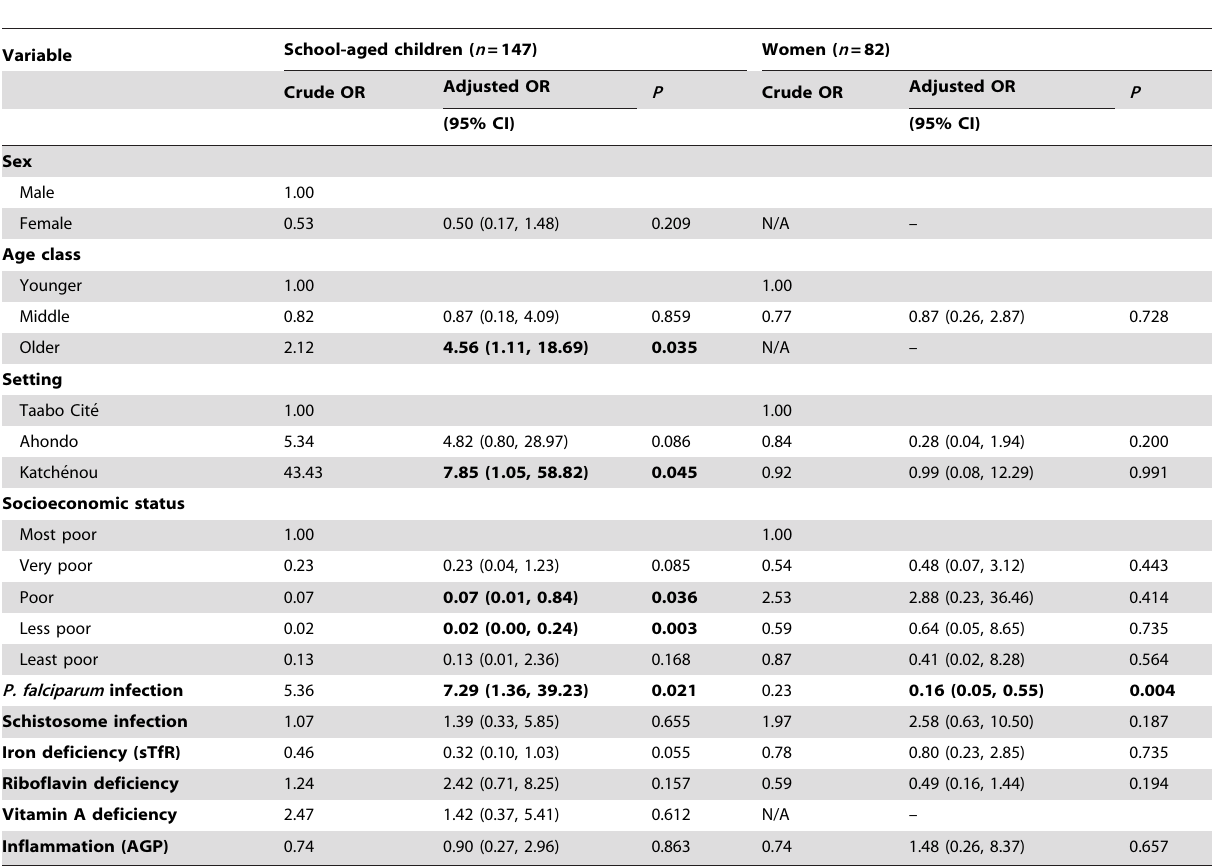
Table 3. Demographic, socioeconomic, parasitological, and micronutrient variables associated with hookworm infection, stratified by school-aged children and